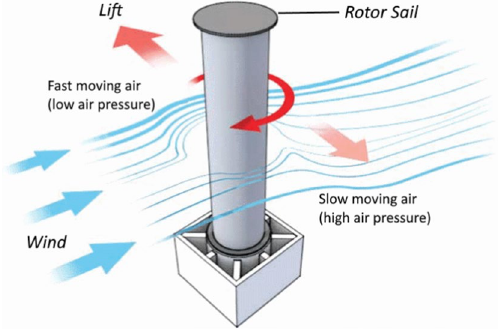
Fig. 5 Working mechanism of Flettner rotor